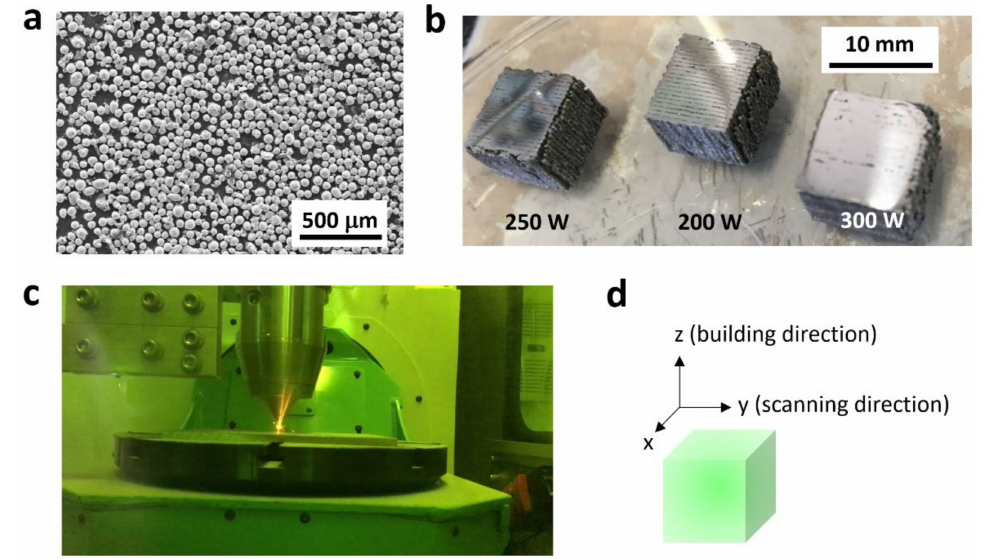
Figure 1. ( a ) SEM image of Fe–Co powder; ( b ) additive-manufactured Fe–Co bulk alloy samples prepared via DED; ( c ) a DED machine (BeAM mobile machine 1.0) during fabrication of the sample;